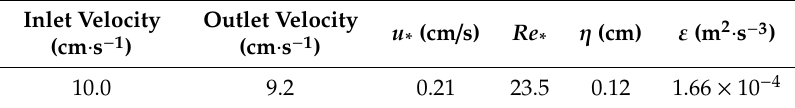
Figure 3. Mean percent concentration ( A ) and velocity ( B ) of the CFD model and physical validation data taken along a vertical gradient 0.5 m downstream from the odorant source. Table 1. Mean statistics for CFD model where initial inlet velocity was set at 10 cm / s. All values are averaged over the entire domain and u * is the friction velocity, Re * is the roughness Reynolds number, η is the Kolmogorov length scale, and ε is the dissipation rate of turbulence.